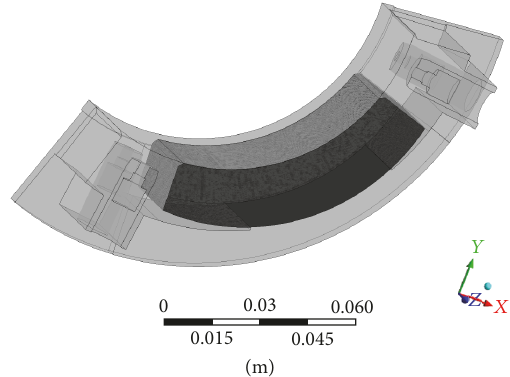
Figure 4: Fluid-model (light grey) and structure-model (dark grey) for CFD